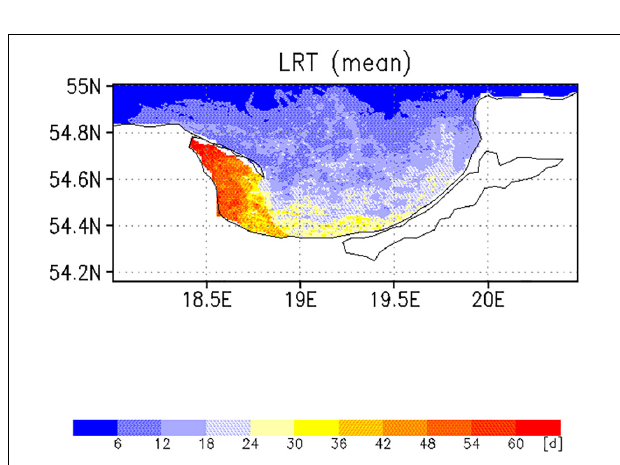
FIGURE 9 | Mean LRT (in days) for the Bay of Gda´nsk during 2009.